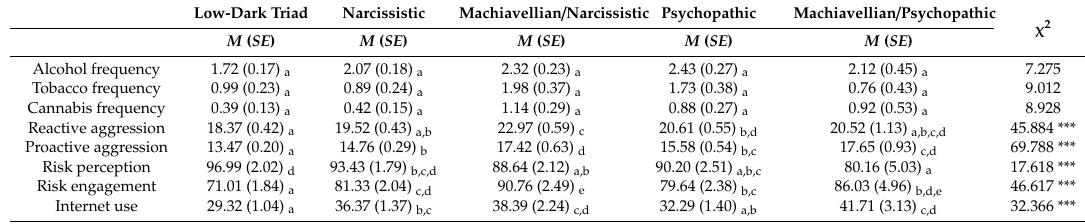
Table 4. Comparisons across subgroups on risky behaviours using the BCH